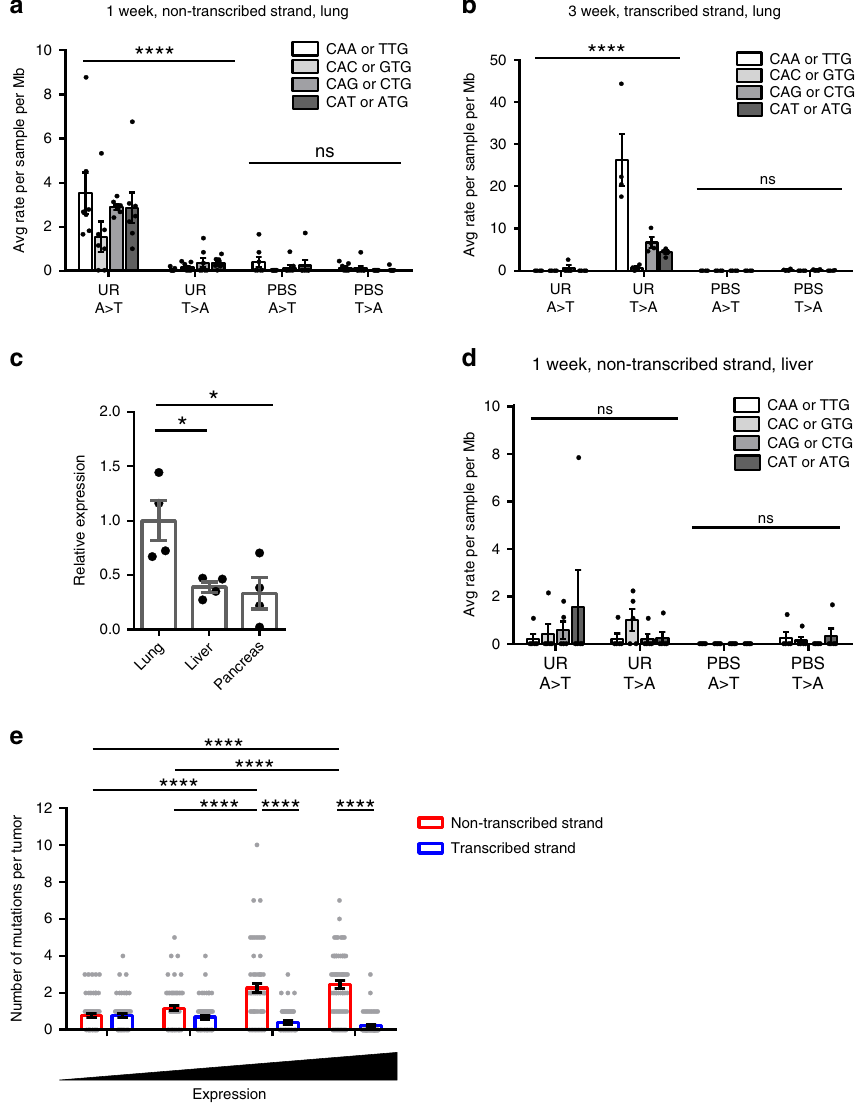
Fig. 5 Urethane strand bias. a , b , d Mean ± SEM mutation frequency of the indicated CAN to CTN transversions and reverse-complementary substitutions averaged by nucleotide positions determined by MDS sequencing of Kras exon 2 ( a ) non-transcribed strand in lungs (Fig. 1, n = 7 mice from one experiment) or ( d ) non-transcribed strand in livers of mice 1 week ( n = 5 mice from one experiment) or ( b ) transcribed strand in lungs of mice 3 weeks ( n = 4 mice from one experiment) after exposure to urethane (UR) or PBS. c Mean ± SEM relative expression of Kras mRNA in the lung, liver, and pancreas (normalized to lung) of mice determined by RT-qPCR ( n = 4 mice from one experiment). e Mean ± SEM frequency of CAN to CTN transversions of the non-transcribed versus transcribed strand in urethane-induced tumors from whole-exome sequencing data 3 in genes binned by their mRNA levels from the mouse lung 36 ( n = 66 tumors). p values calculated by Holm-Sidak multiple comparisons test following a , b , d , e two-way ANOVA or c one-way ANOVA. **** p < 0.0001, * p < 0.05 and ns: not signi fi